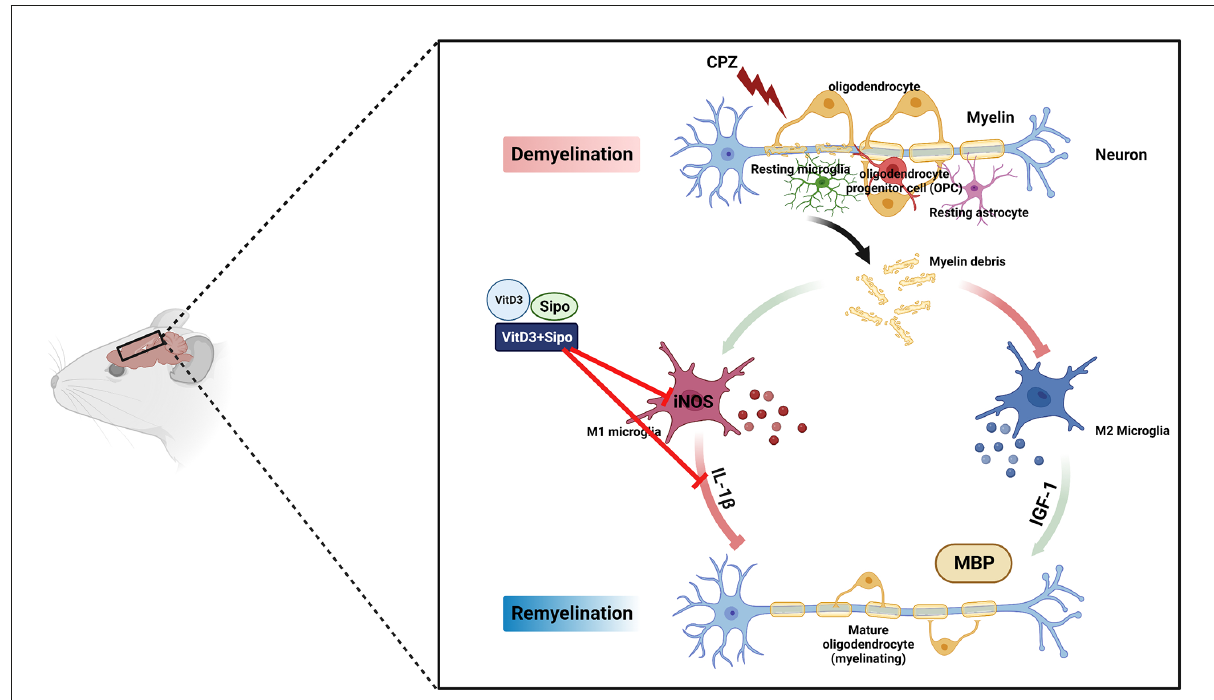
FIGURE10 Schematic representation of the potential therapeutic effects of Vit D3, Sipo, and their combination on gene expression of M1 and M2 microglia markers (iNOS, IL-1 β , IGF-1) and myelination (MBP). CPZ, cuprizone; IL-1 β , interleukin 1 beta; iNOS, inducible nitric oxide synthase; IGF-1, insulin-like growth factor 1; MBP, myelin basic protein; Vit D3, vitamin D3; Sipo, siponimod. Red lines represent inhibitory effects. Created with